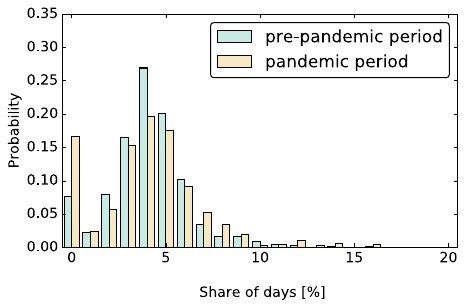
Fig. 8 Share of days with exceptionally high number of messages than mean. The fi gure shows the share of days for each chat where the number of messages was exceptionally higher (two standard deviations of the number of messages per day) than its mean. The values of the pre- pandemic period are colored in blue while the values of the pandemic period are marked in